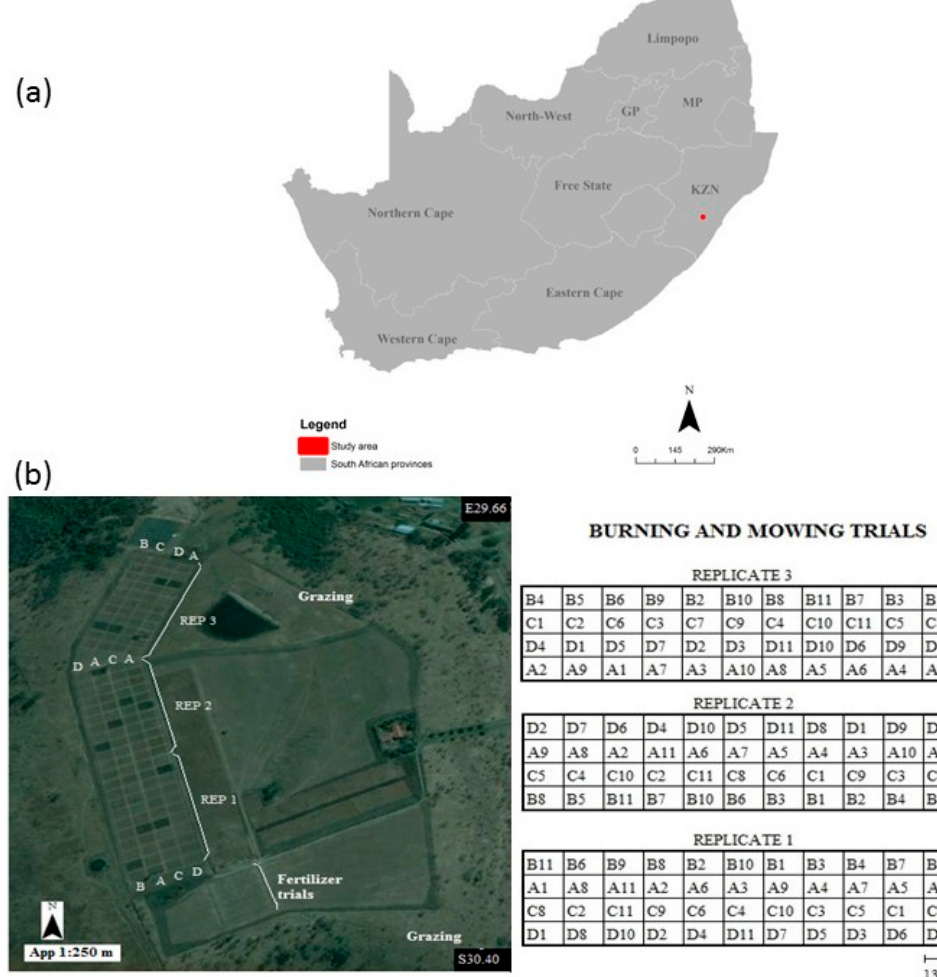
Figure 1. ( a ) Location of the grassland sites at Ukulinga University of KwaZulu-Natal experimental Farm, Pietermaritzburg, South Africa; ( b ) shows the experimental setup and design at Ukulinga research farm (Image source: Google Earth).